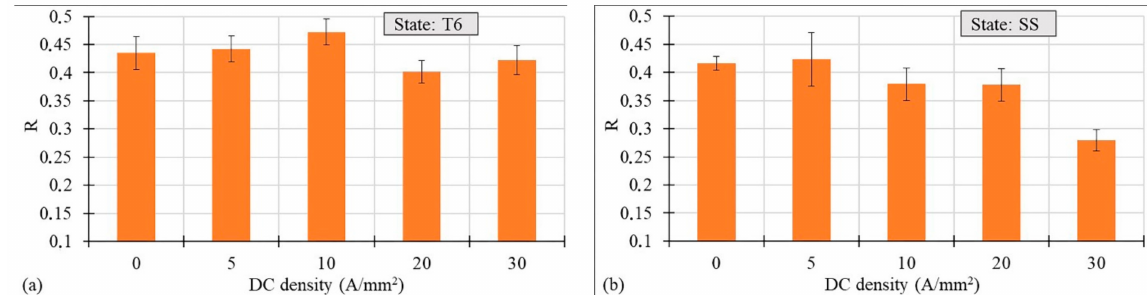
Figure 8. R-value vs. DC density for the AA7075-T6 ( a ) and SS ( b ) states. The influence of the applied current density on the maximum amplitude of the